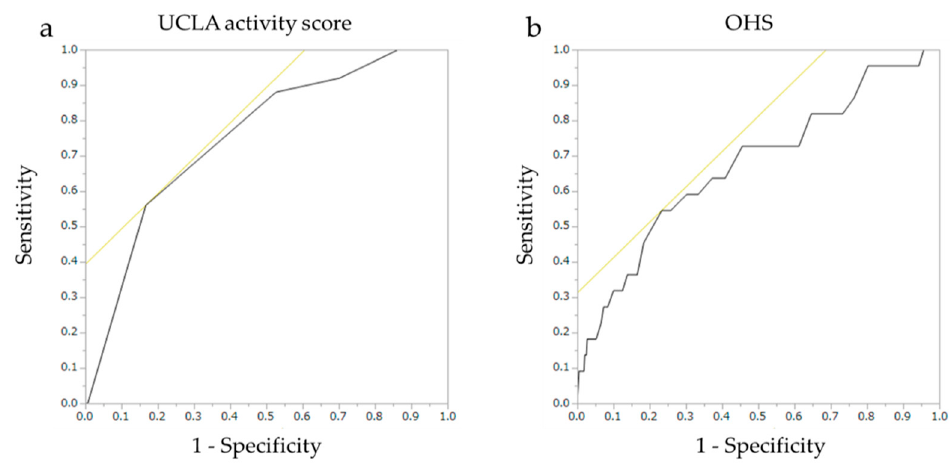
Figure 1. The ROC curves of the ( a ) UCLA activity score and ( b ) OHS. ROC, receiver operating characteristic; UCLA, University of California Los Angeles; OHS, Oxford Hip Score.